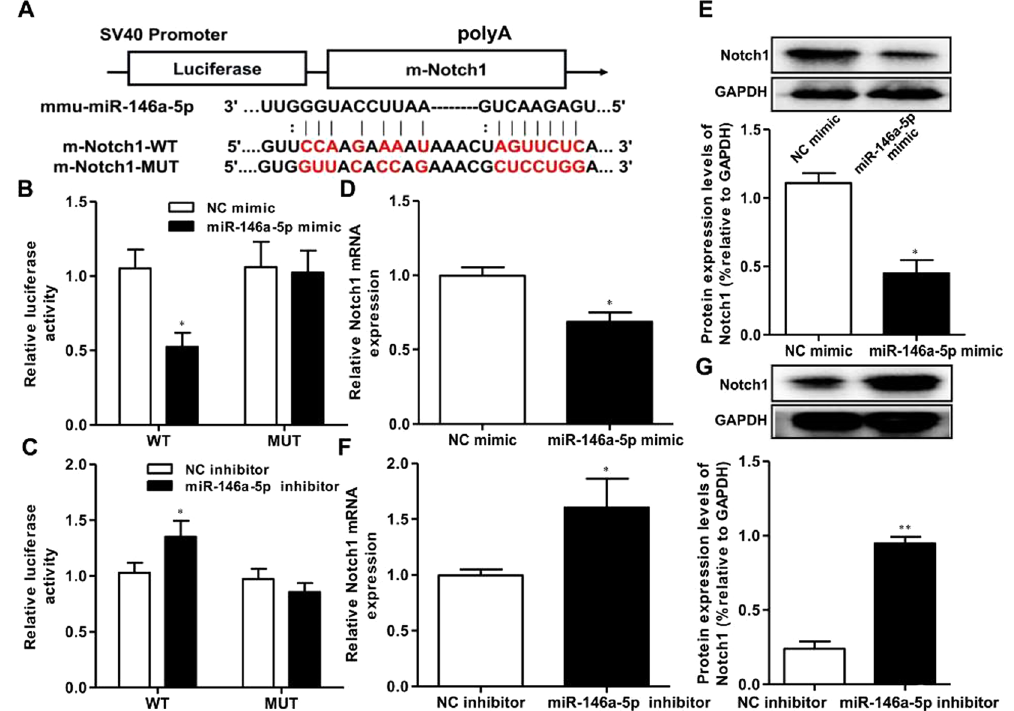
Figure 7. MiR-146a-5p regulate Notch1 expression in BV2 microglia cells. ( A ) The Notch1 was predicted as a target of miR-146a-5p by online bioinformatics methods (Target Scan and microrna.org). ( B , D , E ) The luciferase activity, the mRNA and protein expression of Notch1 were declined in BV2 microglia cells co-transfected with Notch1-3 ′ UTR-WT and miR-146a-5p mimic. ( C , F , G ) The luciferase activity and the gene and protein expression of Notch1 were elevated in BV2 microglia cells co-transfected with Notch1-3 ′ UTR-WT and miR- 146a-5p inhibitor. Data are represented as mean ± SD, * P < 0.05, ** P <